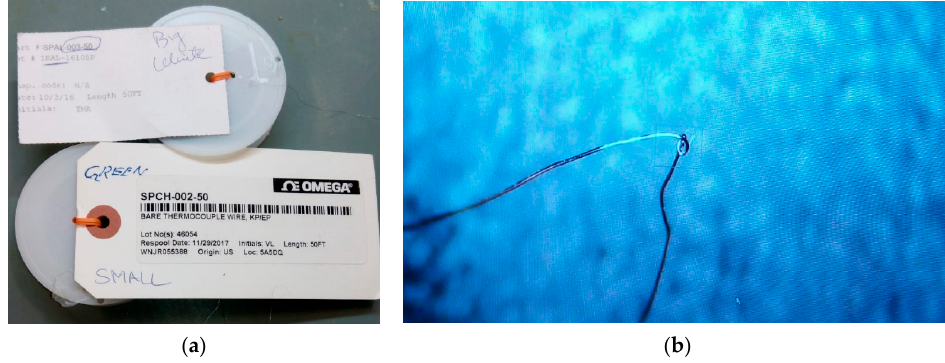
Figure 9. K ‐ type 50 μ m thermocouple: ( a ) 50 μ m Chromel and Alumel wires; ( b ) Bead size of fabricated 50 μ m K ‐ type Figure 9. K-type 50 µ m thermocouple: ( a ) 50 µ m Chromel and Alumel wires; ( b ) Bead size of thermocouple. fabricated 50 µ m K-type